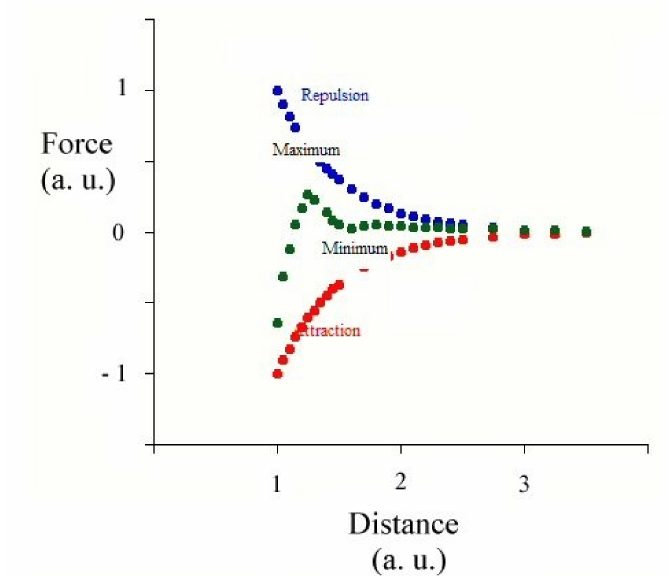
Figure 5. Schematic view of the forces acting among two colloids or surfaces vs. distance: repulsive (light blue), electrostatic, and vdW (red) forces are considered. The result (in green) is the sum of these contributions. The minimum in the curve refers to stability. The position and amplitude of either maxima and minima in the green curve depend on the ionic strength of the